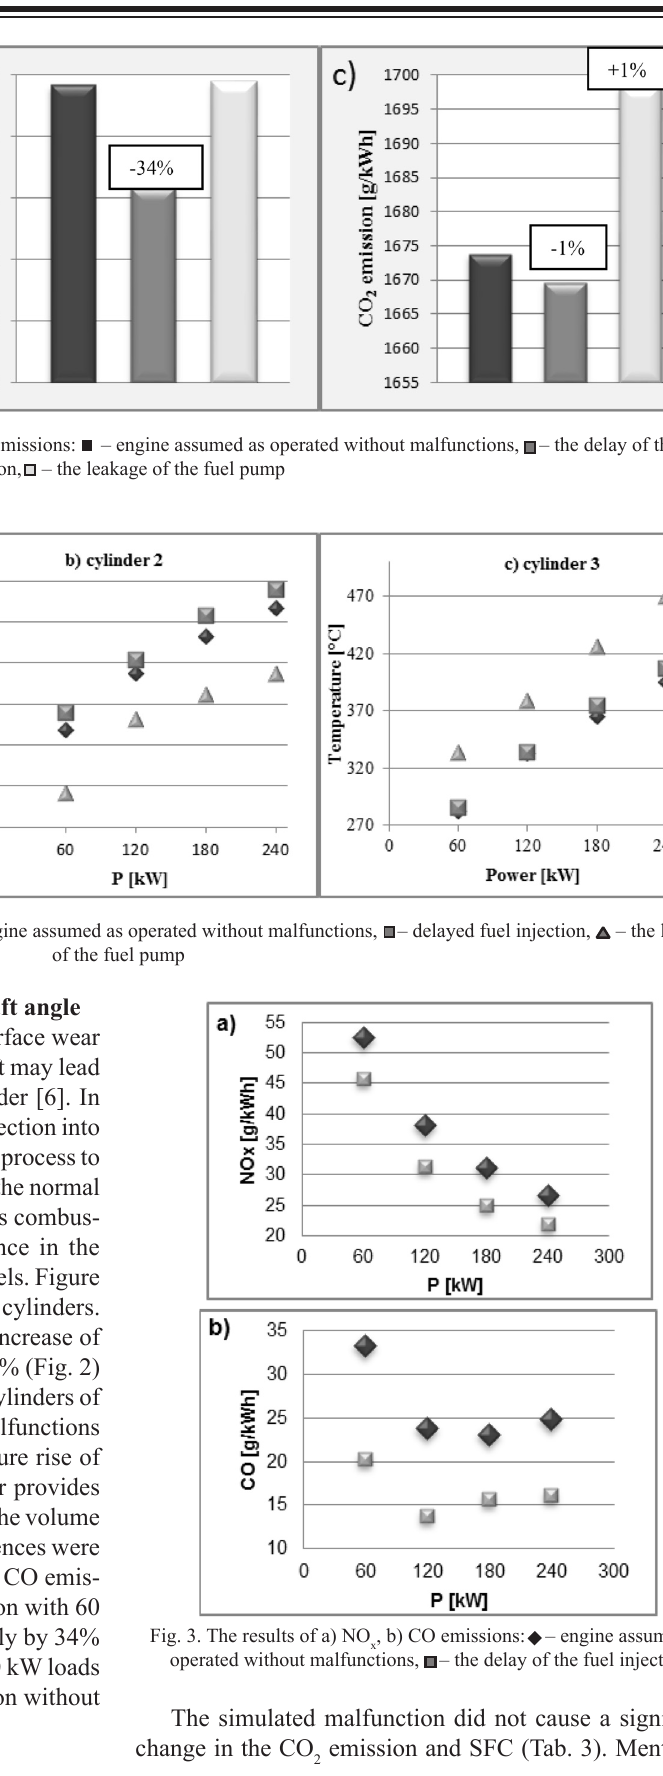
The influence of fuel injection pump